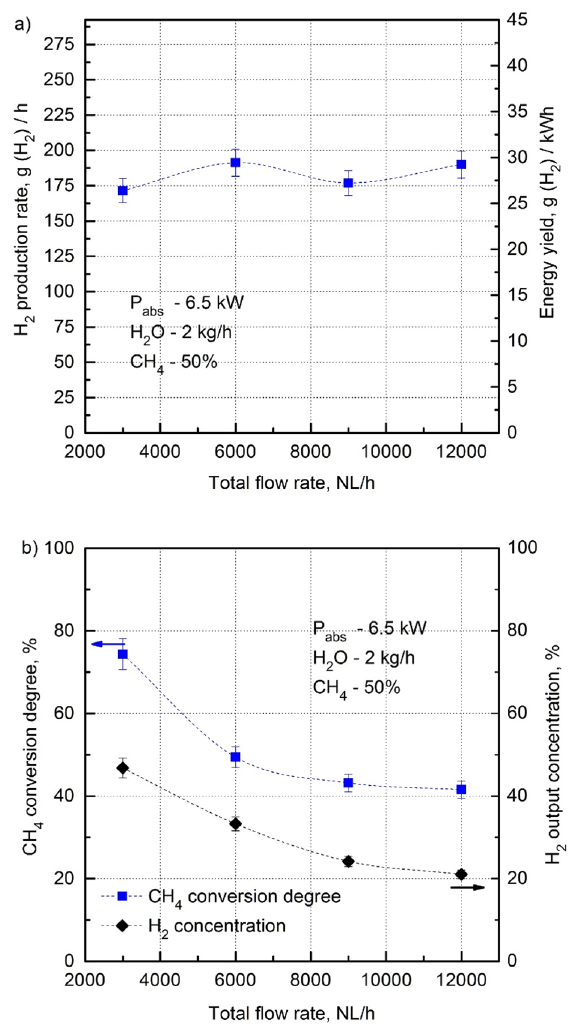
Figure 7. H 2 production rate, energy yield ( a ), CH 4 conversion degree and H 2 output concentration ( b ) as a function of the total flow rate of the CH 4 :CO 2 mixture (P abs —6.5 kW, H 2 O steam —2 kg/h, CH 4